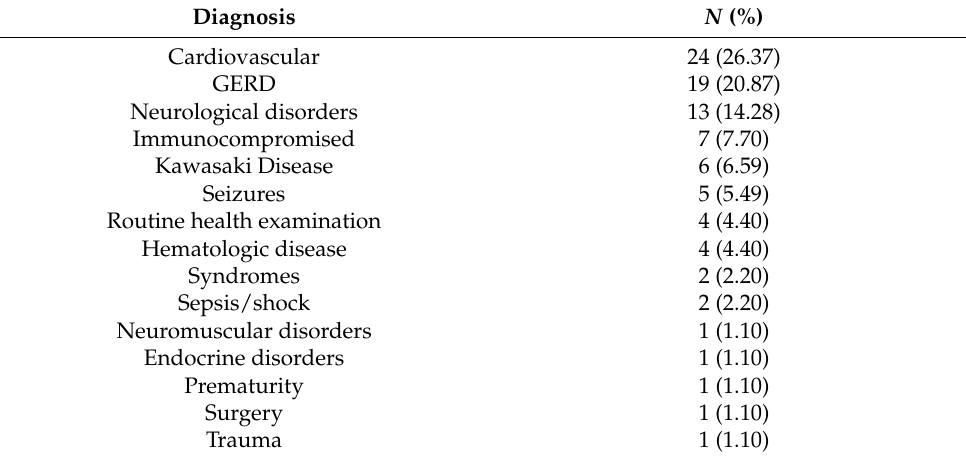
Table 2. Diagnosis in patients with incidental rhinovirus (RV) detection ( n = 91).